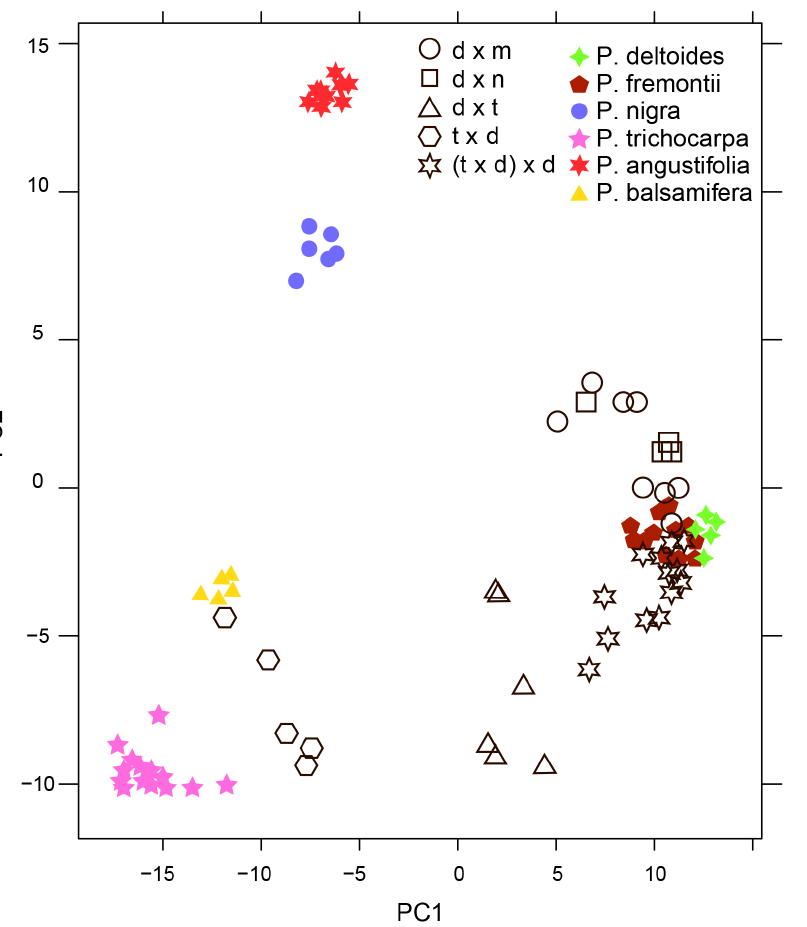
Figure 9. Compositional differences in Populusspp. resin. PCA scores plot of resin ‘fingerprints’ from 11 different Populus spp. and hybrids grown under greenhouse conditions. Pure species are indicated by closed shapes, while hybrids are indicated by open shapes. 49.11% of the total variation in the data set is shown. d x m = P. deltoides x maximowiczii (N=8), d x n= P. deltoides x nigra (N=4), d x t= P. deltoides x trichocapra (N=6), t x d= P. trichocarpa x deltoides (N=5), (t x d) x d= P. (trichocarpa x deltoides) x deltoides (N=14). N=6 for P. deltoides and P. nigra , N=12 for P. fremontii , N=14 for P. trichocarpa , N=18 for P. angustifolia , N=5 for P. balsamifera .